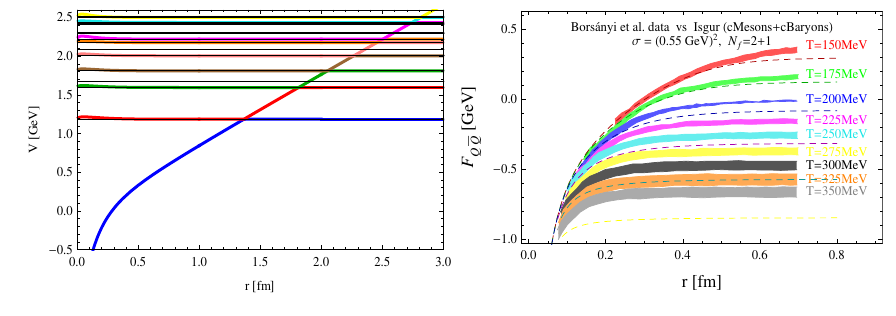
Figure 3. Avoided level crossing spectrum with multiple mixing as a function of distance with RQM using c-quark (left pane) extracted in [6] from the ¯ QQ free energies obtained on the lattice [22] (right